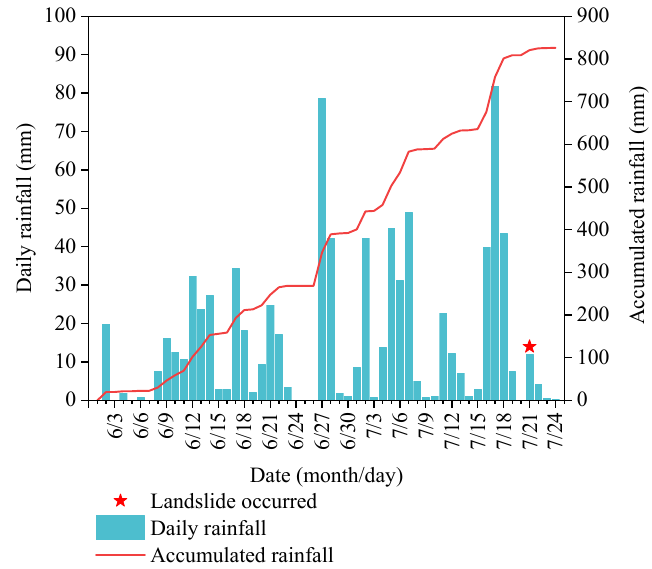
Figure 4. Accumulated and daily rainfall data of Shaziba landslide.